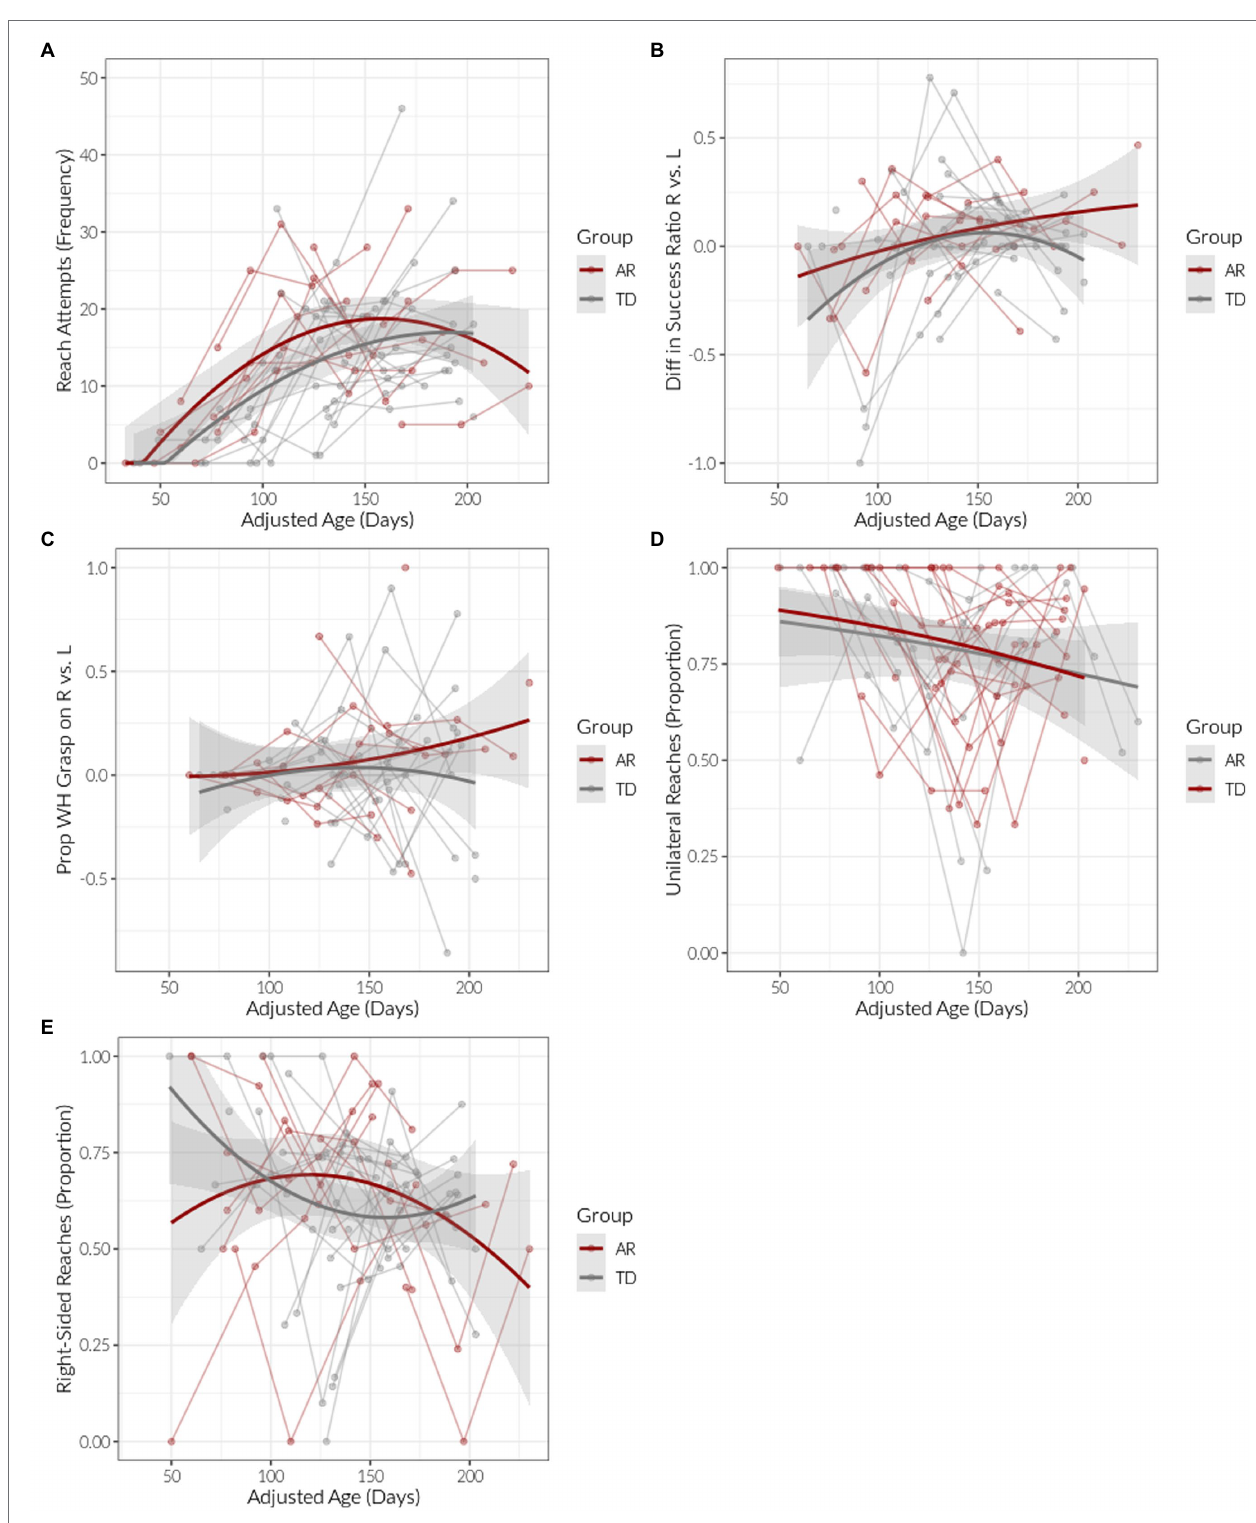
FIGURE 3 | Reaching hand use outcomes by age (adjusted for prematurity as appropriate) for infants at risk (AR) and with typical development (TD). Points indicate observed individual values. Lowess-smoothed lines with 95% confidence bands are also shown. (A) Frequency of reach attempts. (B) Difference in success ratio for right vs. left hands. (C) Proportion of whole hand grasps for right vs. left hands. (D) Proportion of unilateral reaches. (E) Proportion of right arm